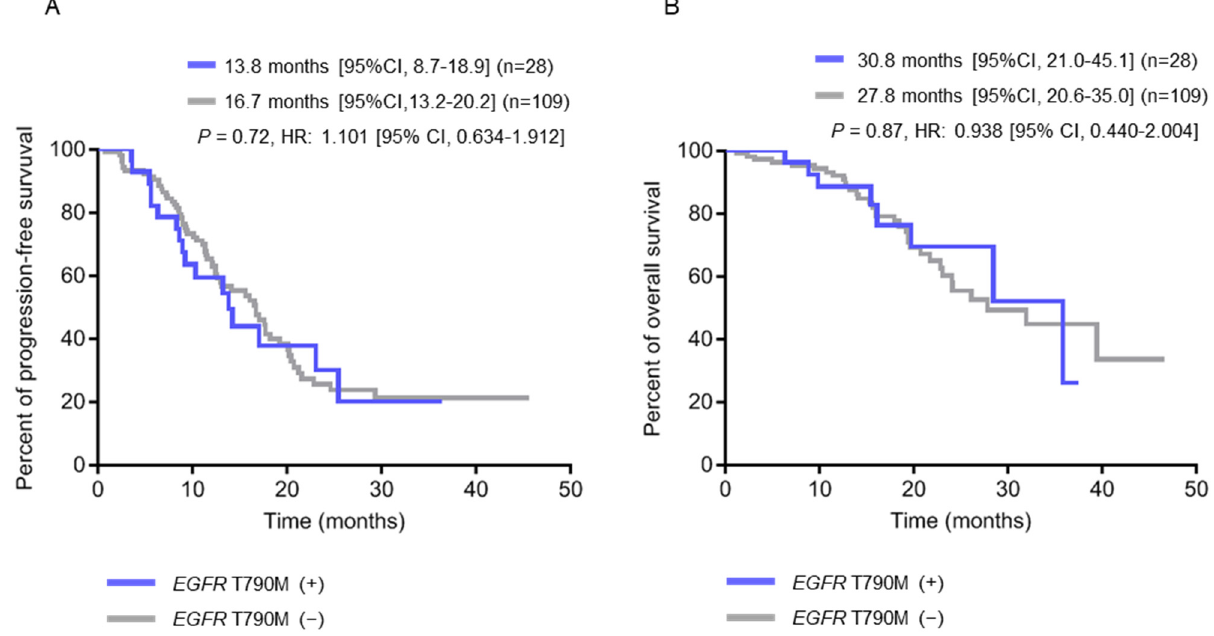
Figure 1. Kaplan-Meier survival analysis according to pre-treatment EGFR T790M status in baseline tumor tissue (N = 137). ( A ) Progression-free survival (PFS) curves. ( B ) Overall survival (OS) curves. Table 3. Patient characteristics stratified by tissue EGFR T790M or plasma EGFR -activating mutation status at baseline (N = 137).